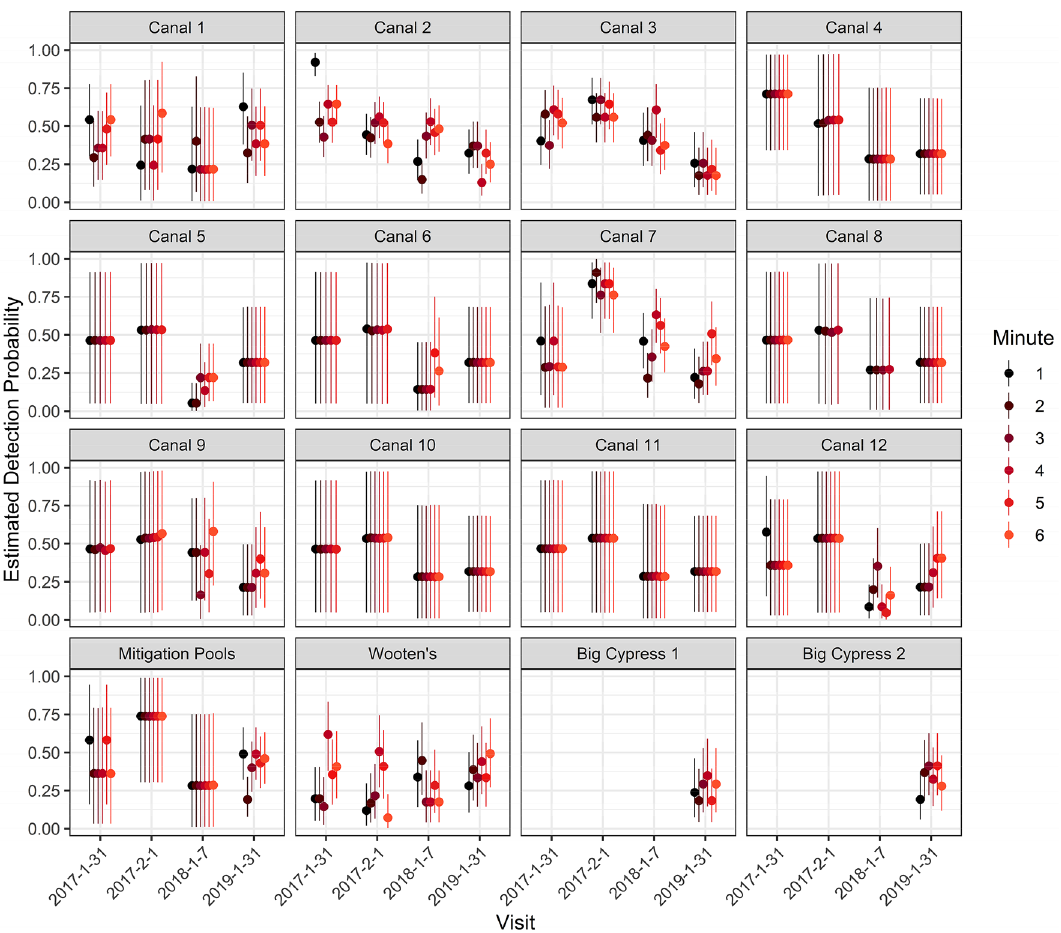
Figure 4. Estimates of the probability of detection for 1-min intervals for 6 min by site, date and min. Dots indicate means (point estimates) and lines the 95% credible